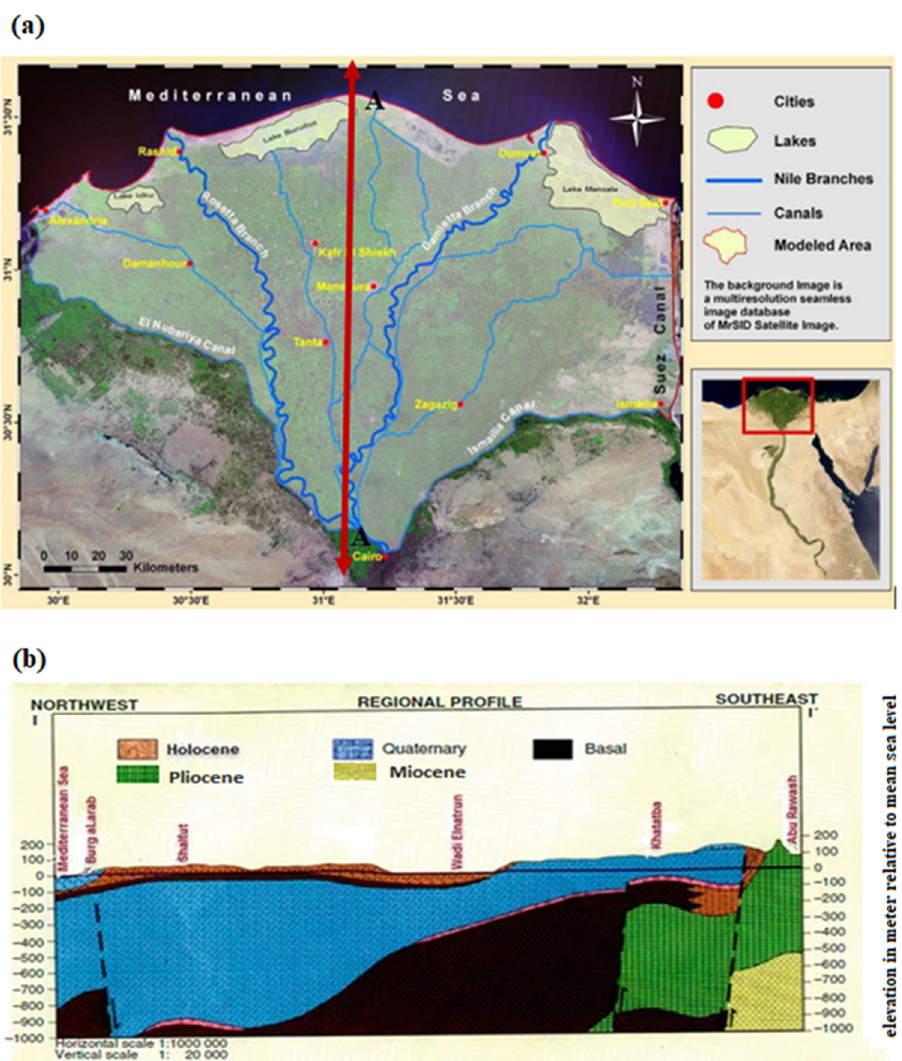
Figure 1. The Nile Delta aquifer, ( a ) the location map [38] ( b ) hydrogeological cross section (A-A) in the NDA [39].